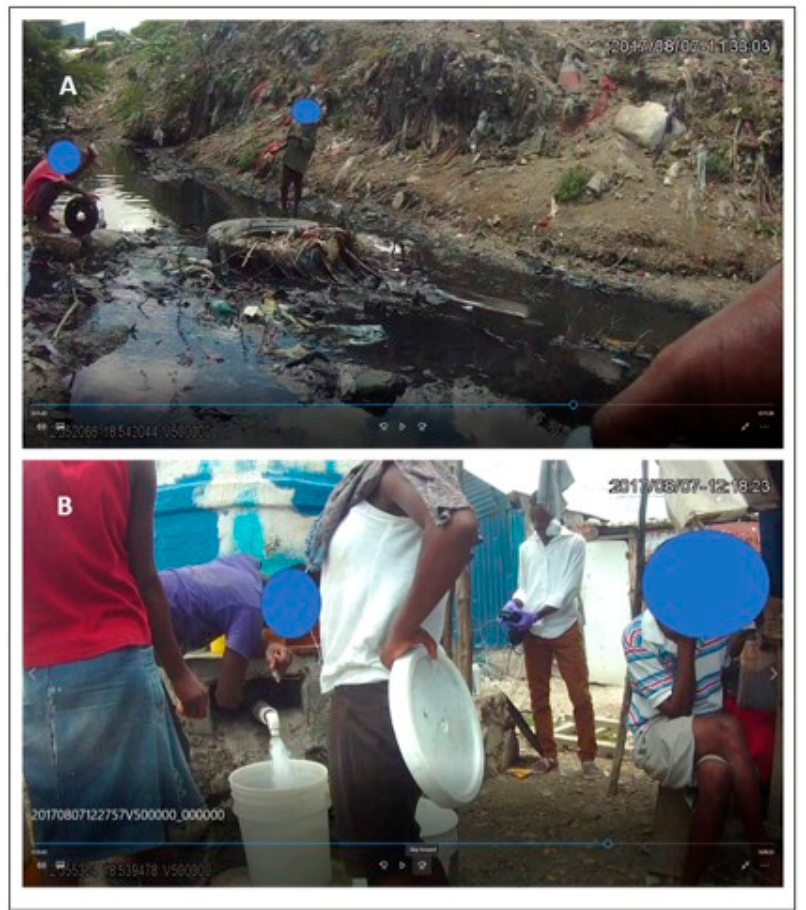
Figure 2. Two example locations of concern; ( A ) is a drainage channel full of trash and waste in which children are playing, and ( B ) is a public water point.